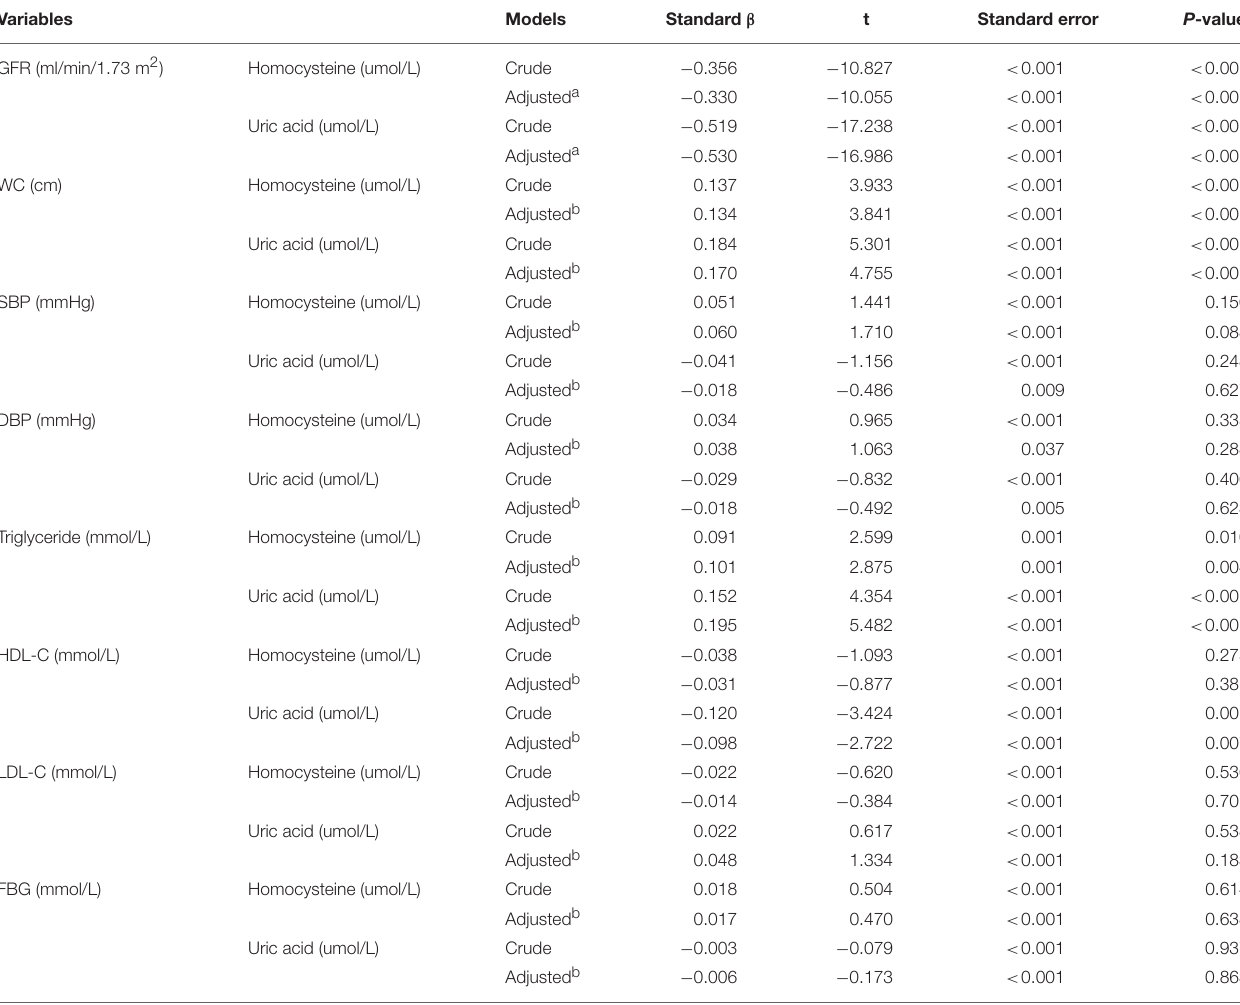
TABLE 3 | Associations of serum homocysteine and uric acid levels with GFR and all features of MetS in Chinese